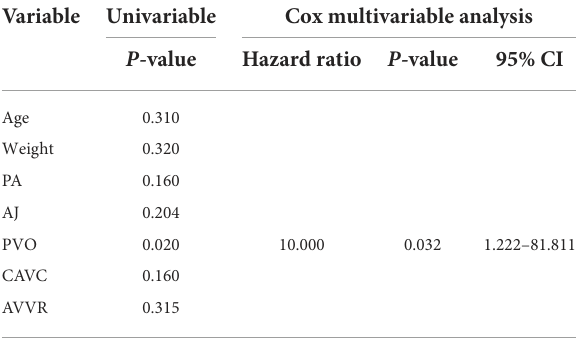
TABLE 3 Analysis of risk factors for